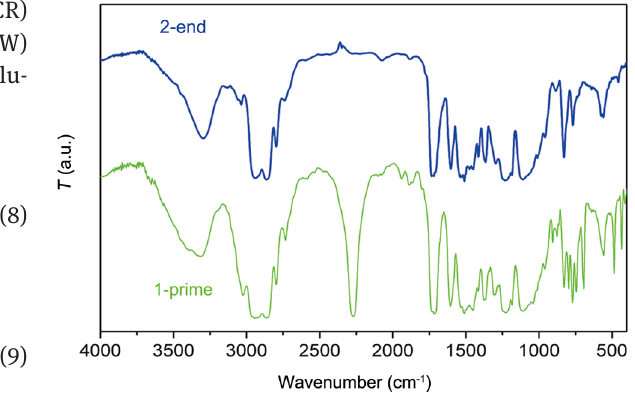
Figure 1 FTIR spectrum for the mixture of DGEBA and polyurethane: 1, prime phase; 2, end